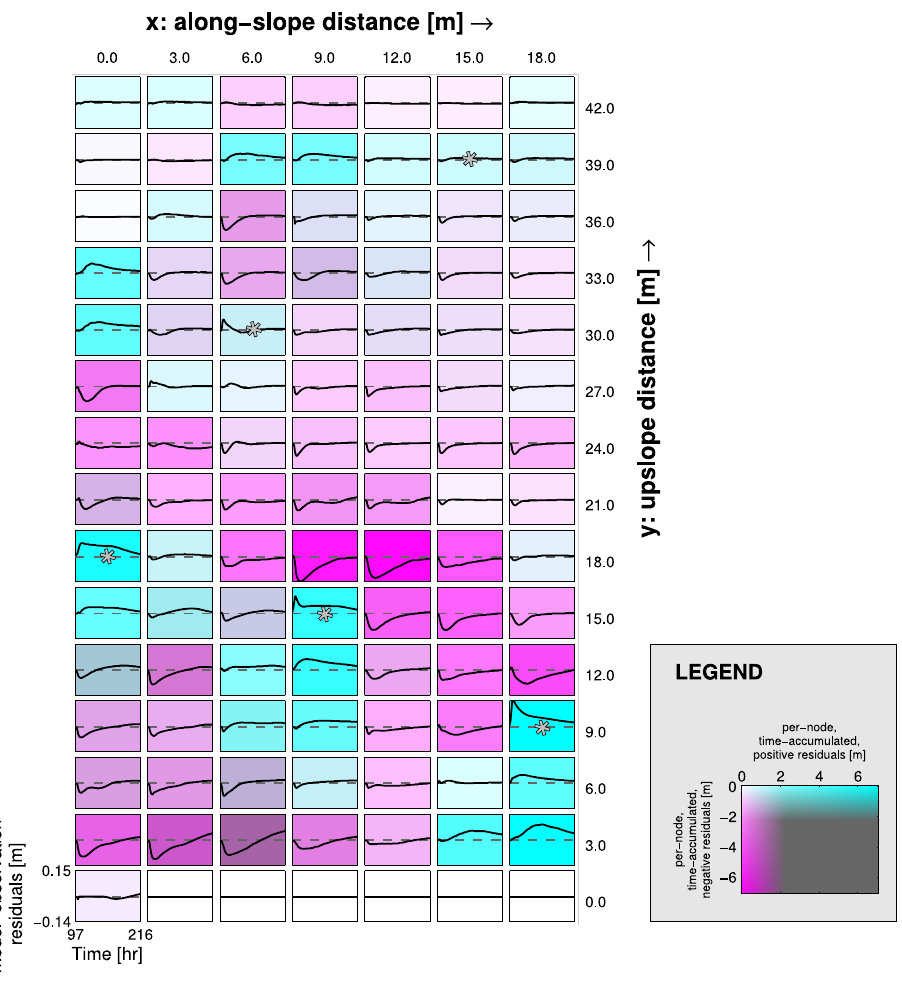
Fig. 5. SCEM-UA (idealized data set): model-observation pressure head residuals in space and time, as associated with the Pareto-optimal parameter combination log 10 (r sink ) ≈ − 1 . 30; log 10 (K s ) ≈ − 0 . 47. For each node at the soil–bedrock interface, the figure contains a subplot showing a time series of model-observation residuals (black line) for t = 97–216h. Horizontal dashed lines represent zero residual. To ease interpretation of the residual pattern, each subplot was assigned a background color depending on the cumulative positive and cumulative negative residual: magenta colors represent under-estimation of artificial measurements (simulated value is too dry), while cyan means over- estimation (too wet). Note the spatial coherence and error propagation. The locations of sink hotspots as used in the reference model (but not the simplified model) are indicated with asterisks.